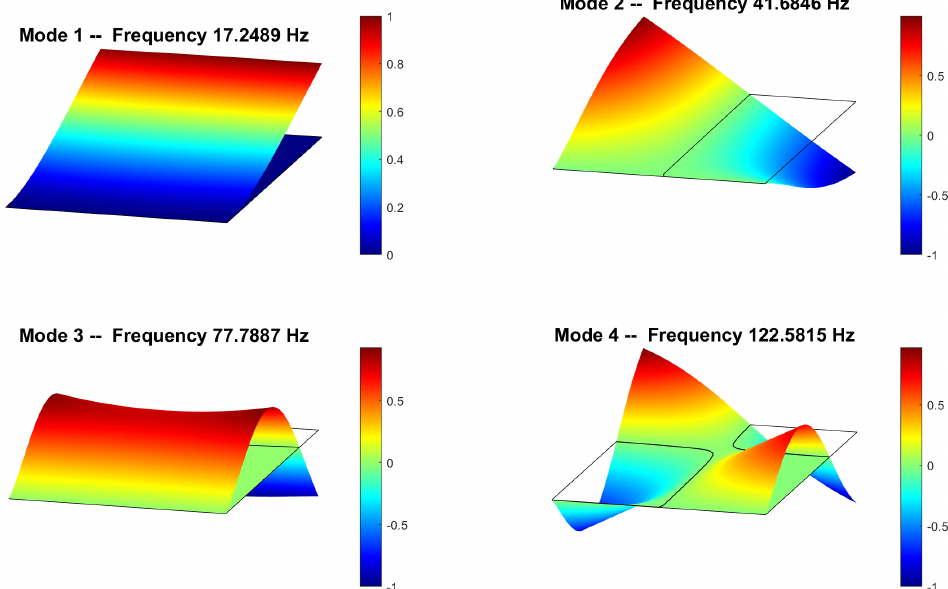
Figure 4. 3D first mode shapes 1, 2, 3 and 4 of the plate